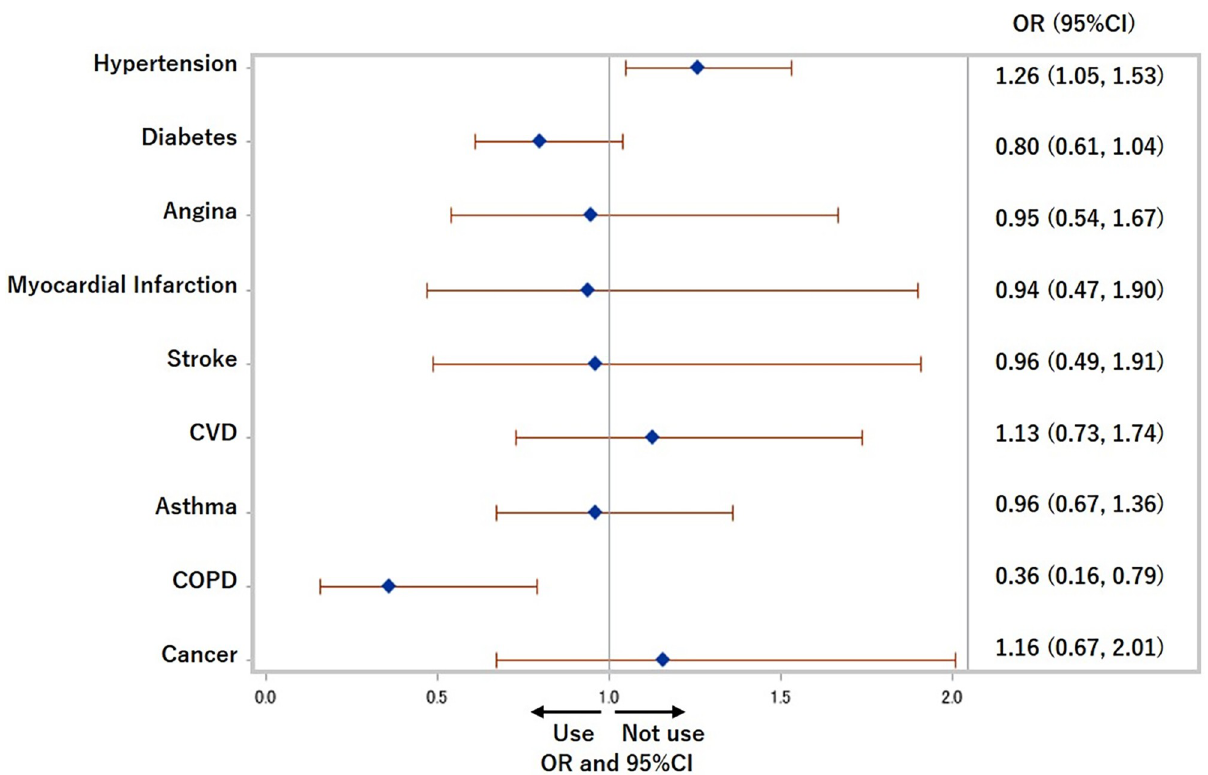
Fig 5. Odds ratios for not using cigarettes nor heated tobacco products in previous 30 days among former and current cigarettes smokers. COPD: Chronic obstructive pulmonary disease, CVD: Cardiovascular disease, OR: Odds ratio. Adjusted for age, sex, equivalent household income, education, and drinking